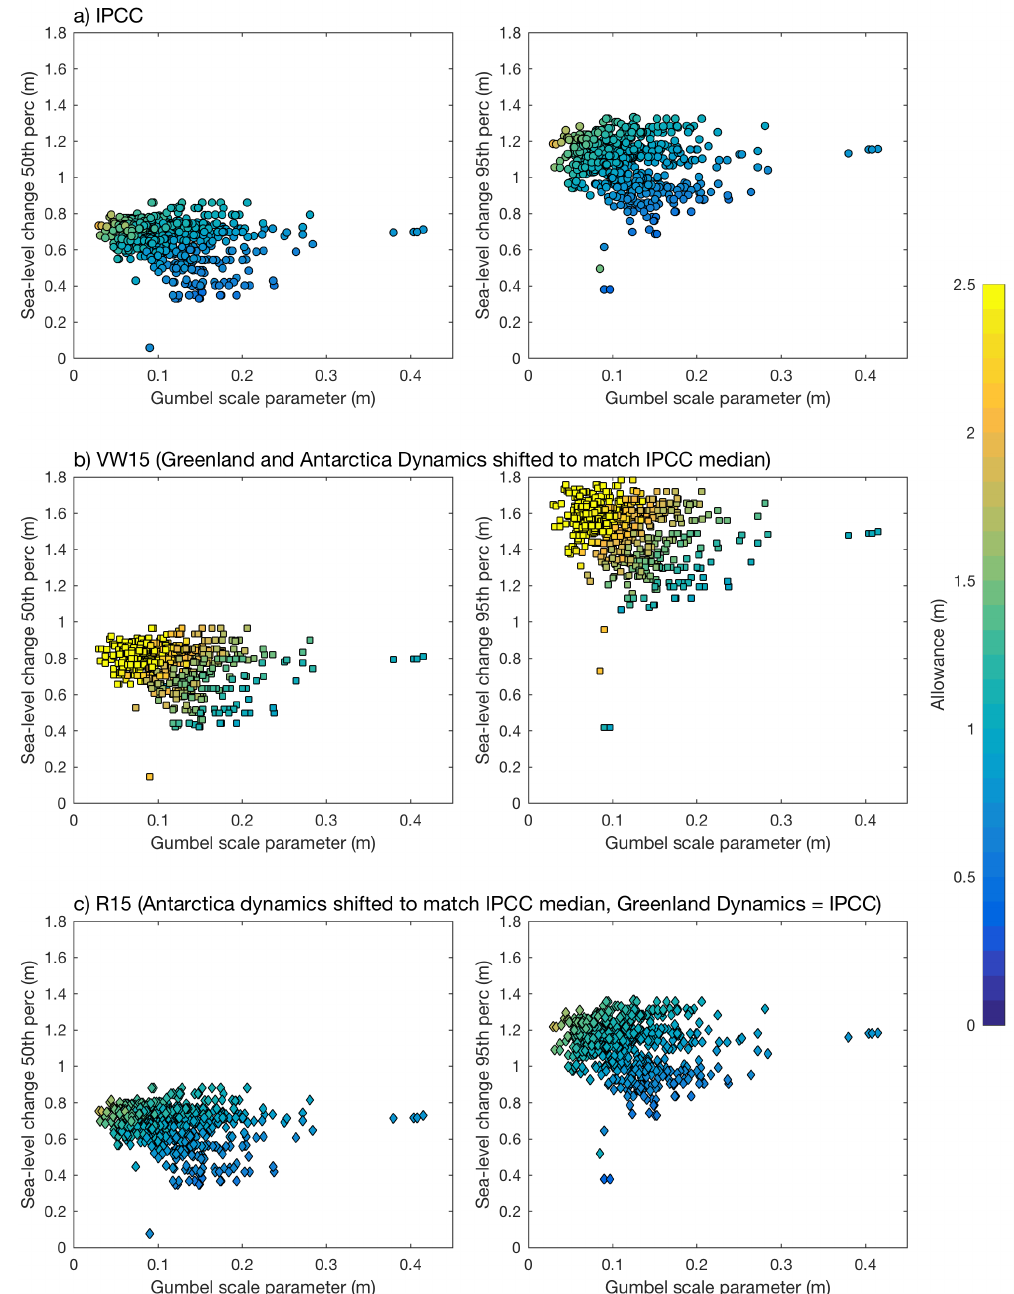
Figure 8. Scatter of 2010–2100 change in sea level (m) median (left column) and 95th percentile (right column) vs. the Gumbel scale parameter (m), colourscale indicating allowance (m), for the three scenarios ( a ) IPCC; ( b ) VW15; ( c )